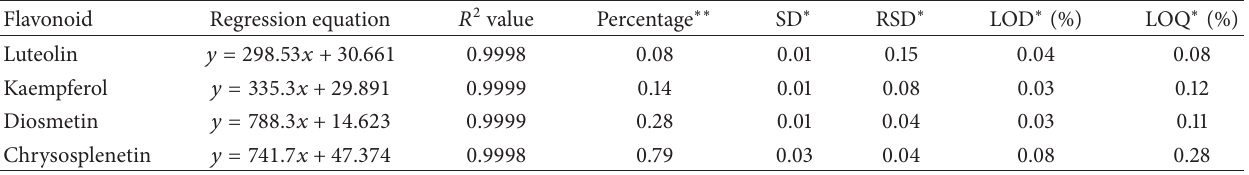
Table 1: Results of the quantification of flavonoids in Dracocephalum heterophyllum Benth. Flavonoid